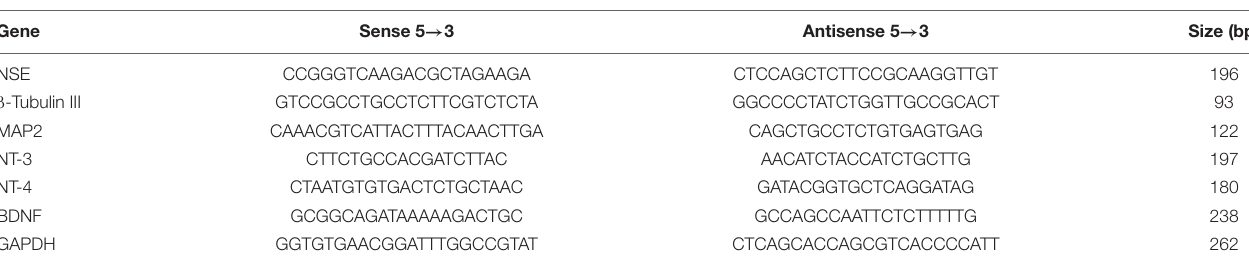
FIGURE 1 | Sketch of the device and differentiation process. (A) Schematic representation of the stretching and electrical field (EF) stimulation device. (B) Detailed structure of fixed and mobile ends and the elastic silicone membrane. (C) Schematic overview of the BMSC neural differentiation process. (D) The pulsed biphasic electrical signal. TABLE 1 | The primers for